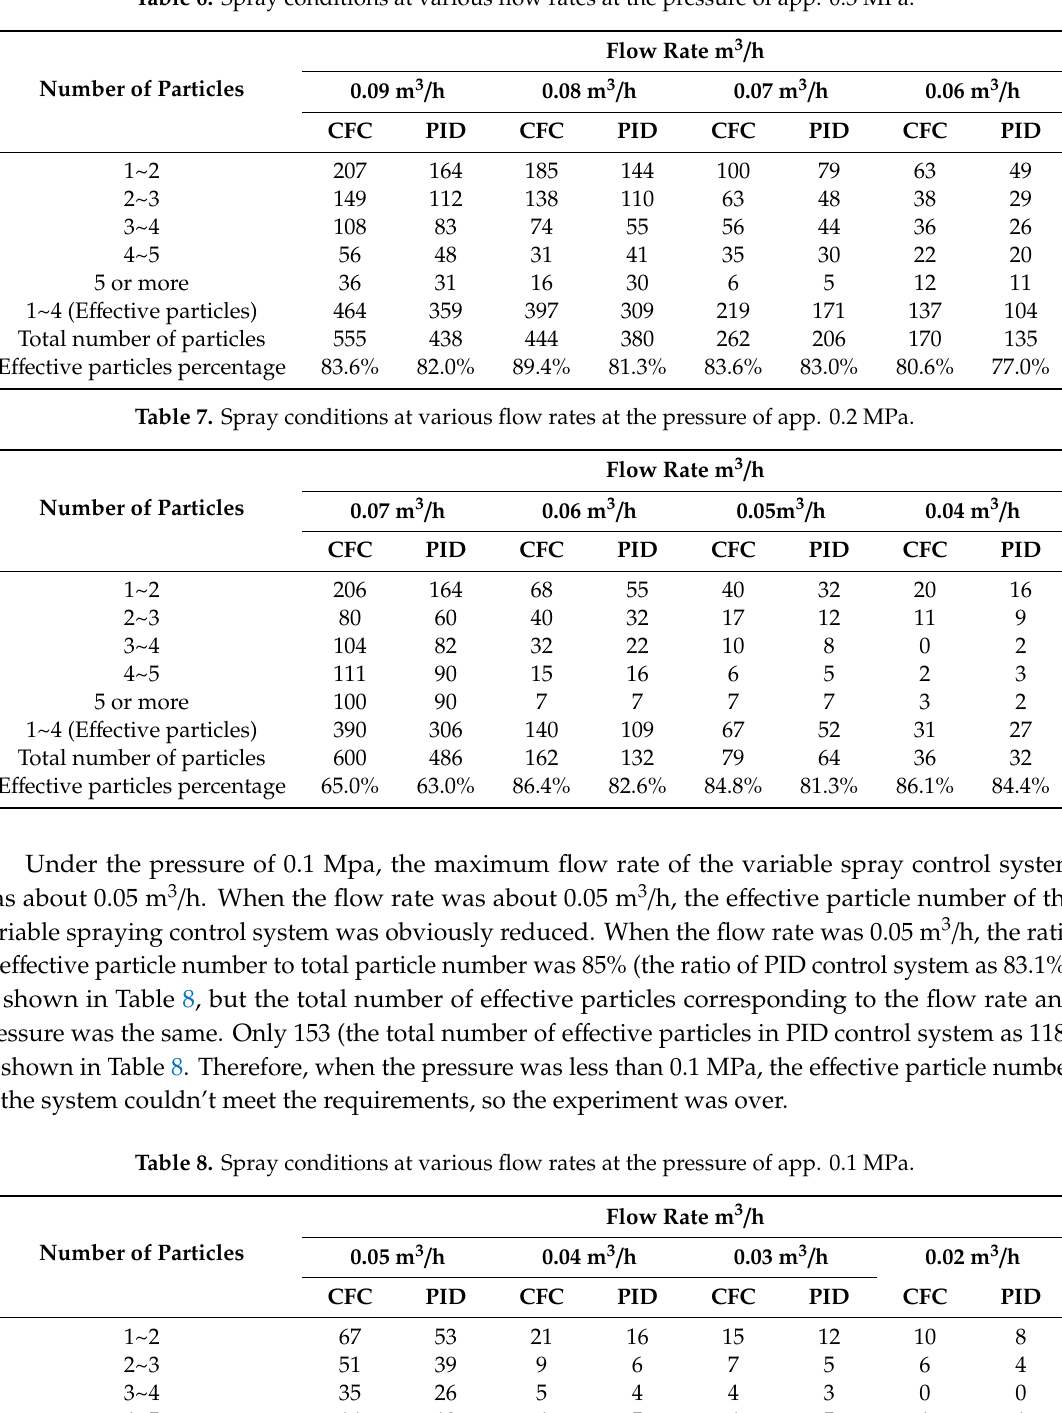
Table 6. Spray conditions at various flow rates at the pressure of app. 0.3 MPa.